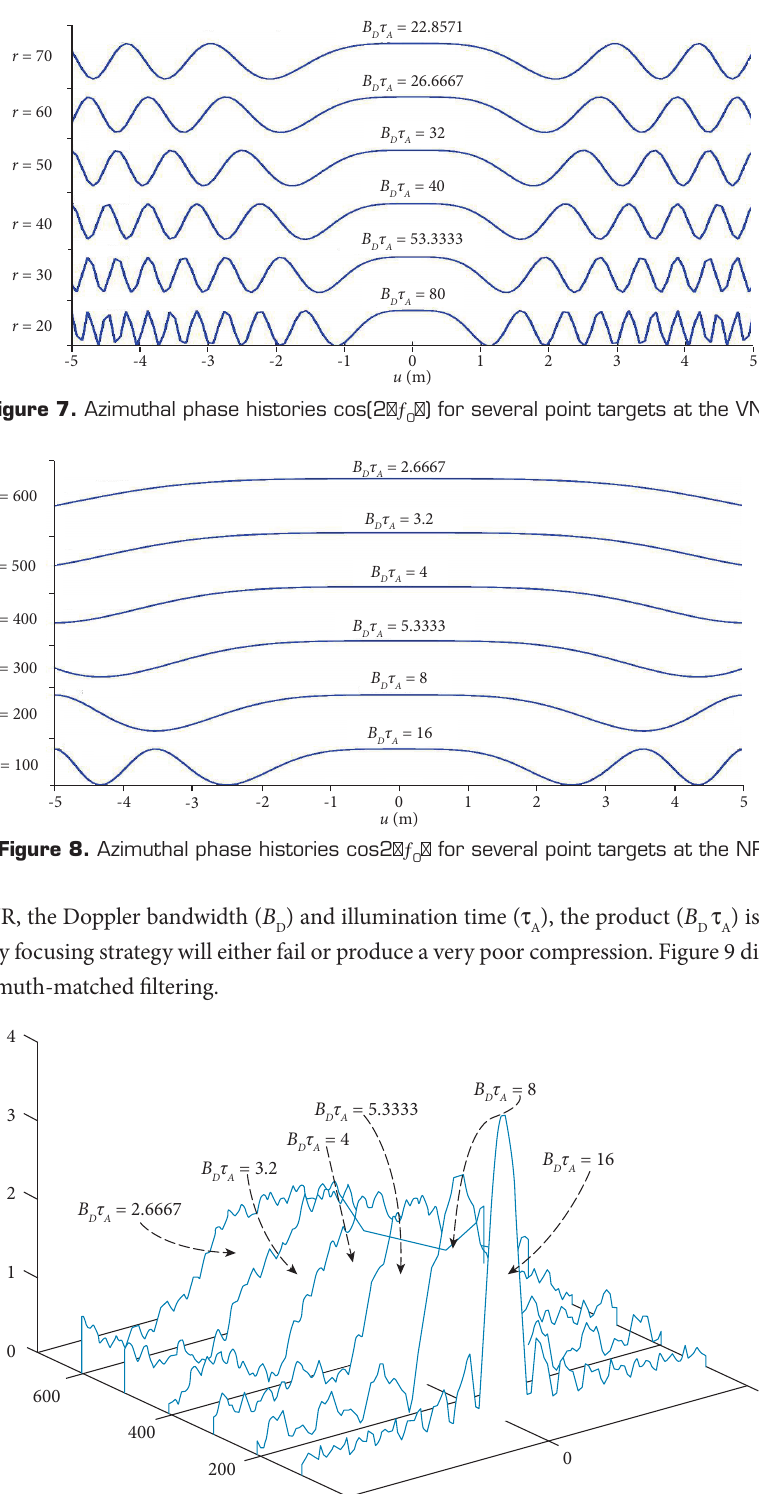
Figure 9. Sinc-like functions resulting from azimuth-matched filtering for targets located at the